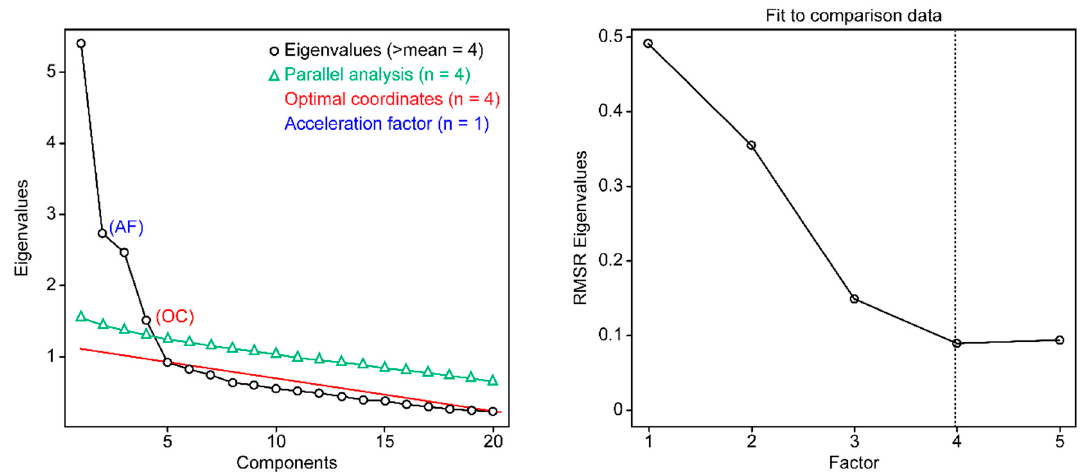
Figure 3. Determining the number of factors to retain through 5 empirical methods for the validation of the 2 new models: 16-item socio-family support scale (SFS-16) and 4-item religious support scale (RSS-4) (subsample B, n = 317).